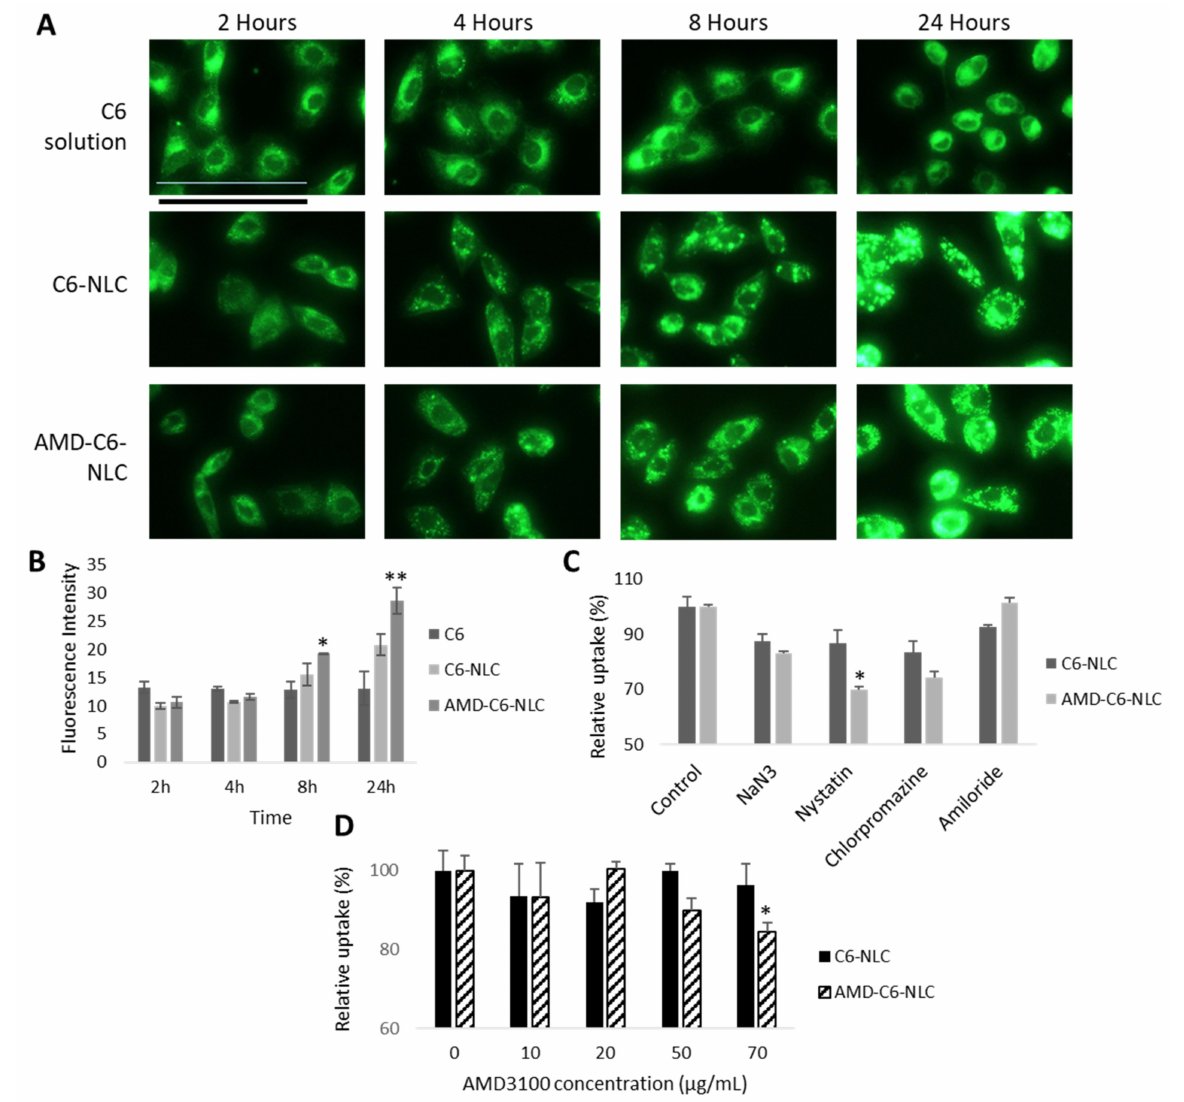
Figure 4. Cellular uptake of C6 solution, C6-NLC and AMD-C6-NLC. ( A ) Representative images of C6 uptake in its free form or when encapsulated in NLC or AMD-NLC after 2, 4, 8, and 24 h of treatment. Scale bar = 50 µ m. ( B ) Time-dependent mean fluorescence intensity of cells after different treatments. Statistically significant differences between C6 solution and AMD-C6-NLC are marked by (* p < 0.05) and (** p < 0.01). All data are shown as mean ± S.D. of three independent replicates. ( C ) Cellular uptake of C6-NLC and AMD-C6-NLC with endocytic inhibitors sodium azide, nystatin, chlorpromazine, and amiloride. ( D ) Cellular uptake of C6-NLC and AMD-C6-NLC with AMD3100 inhibition at different concentrations. Statistically significant differences between C6-NLC and AMD-C6-NLC uptake for C and D are denoted as * p < 0.05. All data are shown as mean ± S.D. of three independent